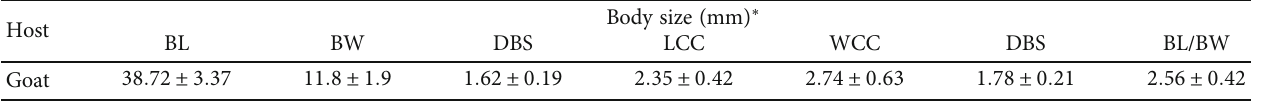
Table 2: Morphometric measures ( mean ± SD ) of liver fl ukes collected from slaughtered goats ( n = 10 ). Host